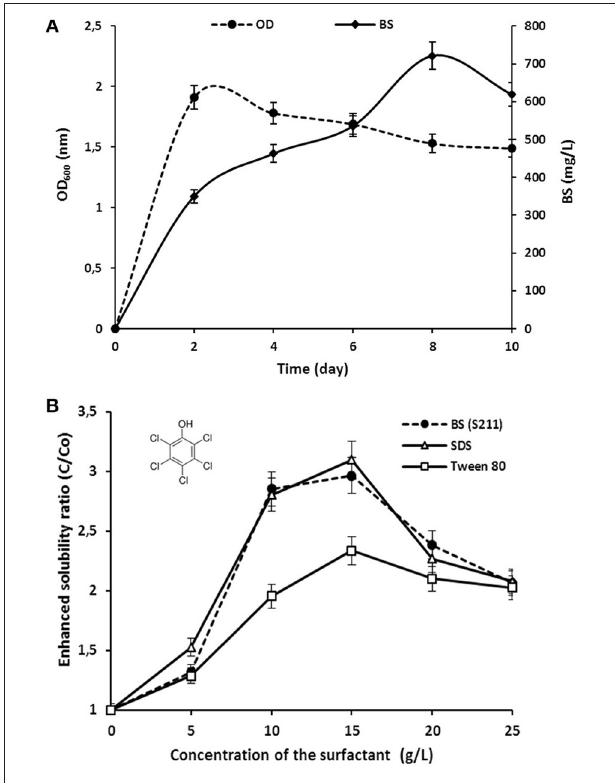
FIGURE 6 | (A) Growth (OD 600nm ) kinetics and BS production by P. rhizophila S211 under optimized conditions; (B) Effect of chemical surfactants and P. rhizophila rhamnolipid BS concentrations on the solubility of PCP.